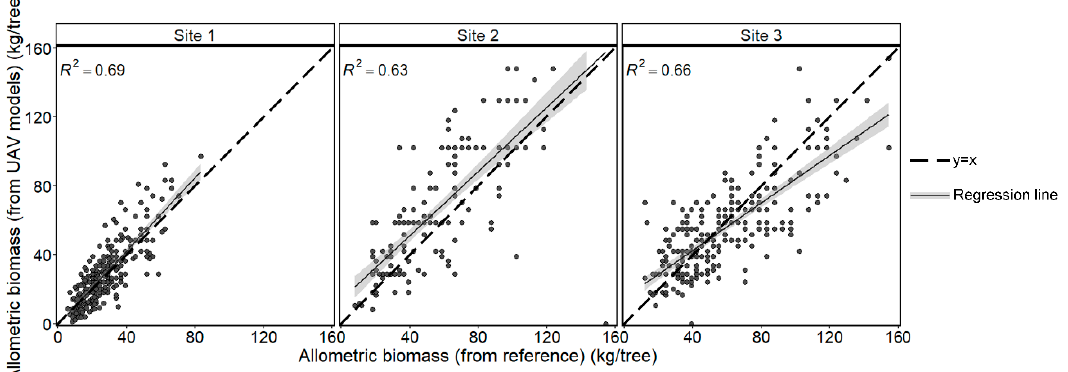
Figure A7. Site-specific AGB values obtained from allometric equations on variables measured by UAV (vertical axis) and reference values (horizontal axis) in coppice stands in Zone 1.